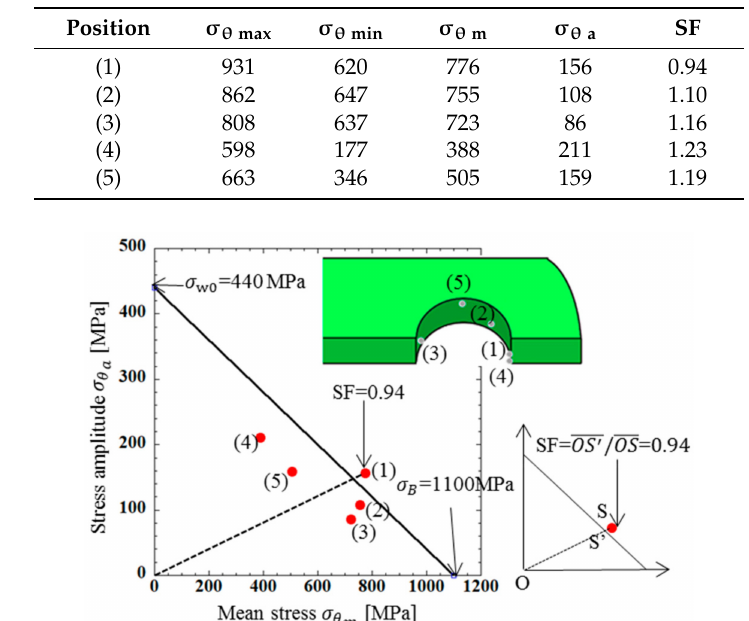
Table 5. Maximum stress σ θ max σ θ max and minimum stress σ θ min , mean stress σ θ m and stress amplitude σ θ a for inner plate [MPa].